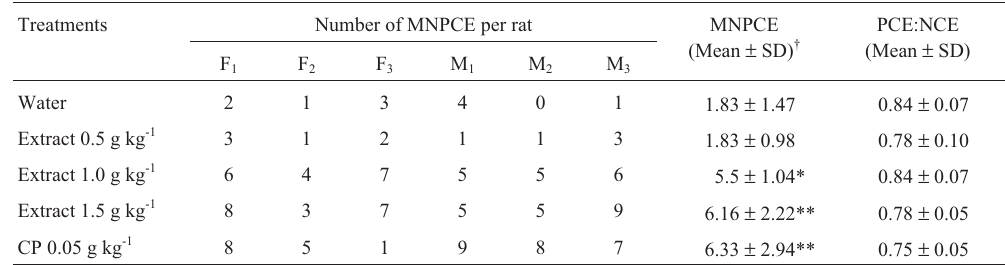
*Significantly different from negative control by the ANOVA and Tukey test at p < 0.05. Table 5 - Micronucleus (MN) test results showing the number of micronucleated polychromatic erythrocytes (MNPCE) bone-marrow samples from fe- male (n = 3; F 1 , F 2 and F 3 ) and male (n = 3; M 1 , M 2 and M 3 ) Wistar rats treated with Piper cubeba seed extract, 2000 cells being scored per rat. The ratio of polychromatic erythrocytes to normochromatic erythrocytes (PCE:NCE) was also calculated, 1000 cells being scored per rat. SD = standard deviation. Negative control = water, positive control = cyclophosphamide